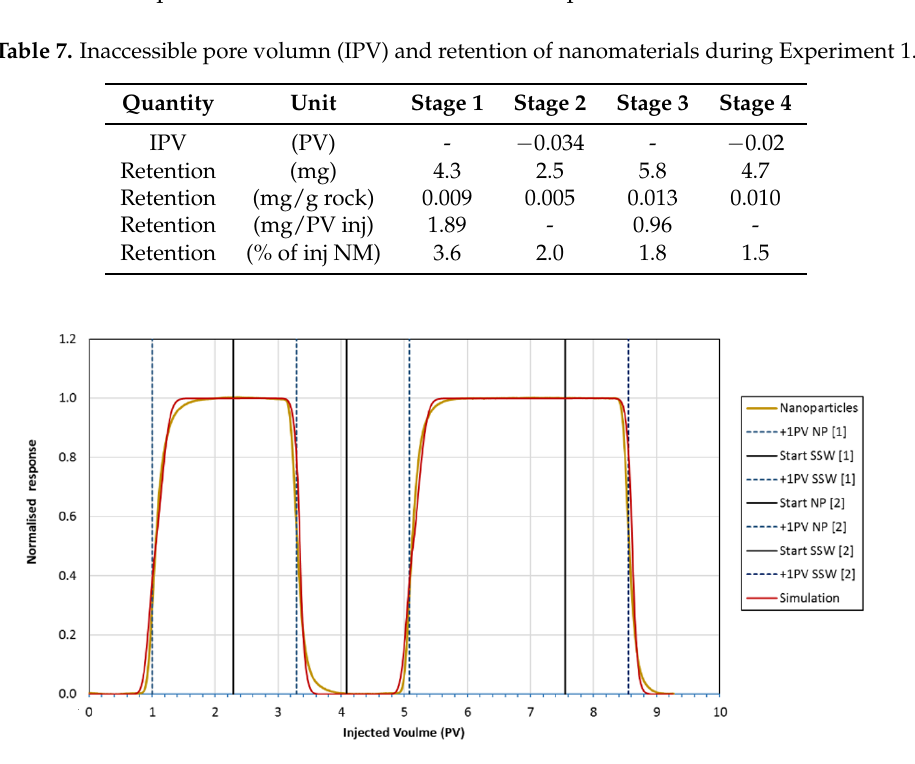
Figure 10. Comparison of normalized nanomaterial concentration at the outlet of the core from the experiment and simulation of Experiment 1 (Bentheimer): The normalized nanomaterial response is plotted as function of injected pore volume